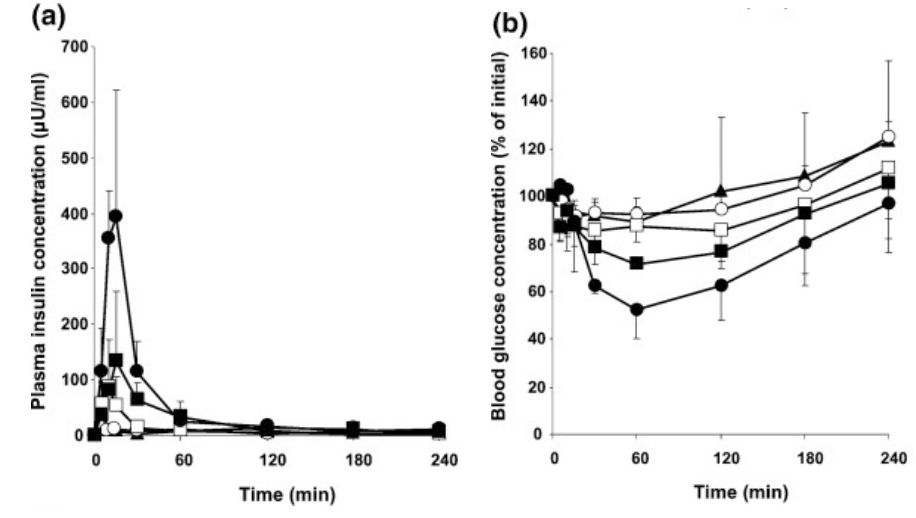
Figure 4. Plasma insulin (a) and blood glucose (b) concentration vs. time profiles following nasal administration of insulin (10 IU/kg) with different CPPs (0.5 mM). Each data point represents the mean ± SEM ( n = 3). Key: ( ▲ ) insulin; ( ○ ) L-R8 (specific L-penetratin); ( □ ) D-R8 (specific D-penetratin); ( ● ) L -penetratin; ( ■ ) D -penetratin [reprinted with permission from Ref. [64], copyright Elsevier